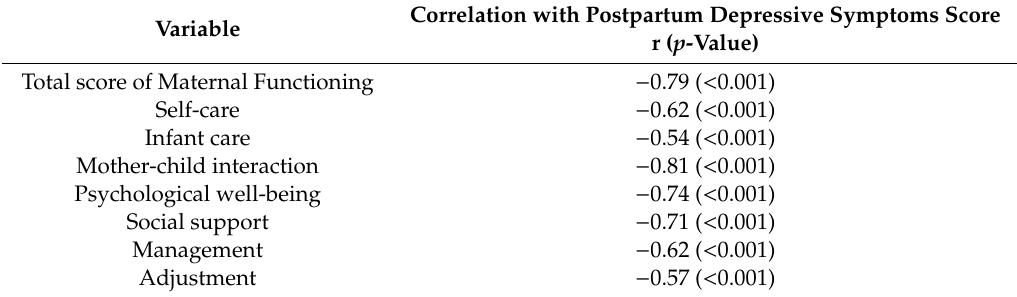
Table 3. Correlation of maternal functioning and its dimensions scores with postpartum depressive symptoms score.